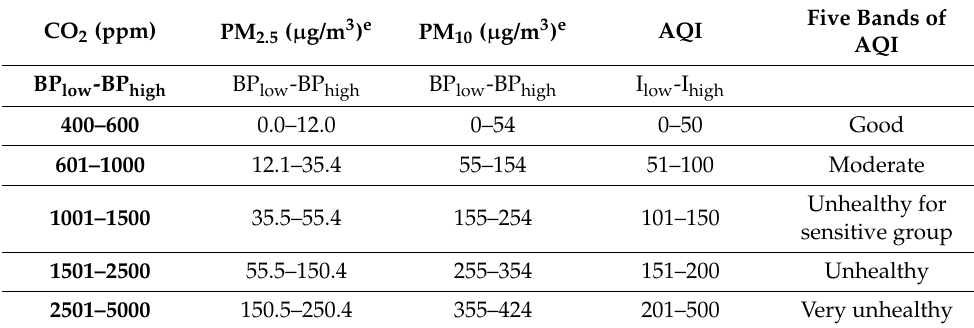
Table 3. Concentration Value for Measuring AQI.